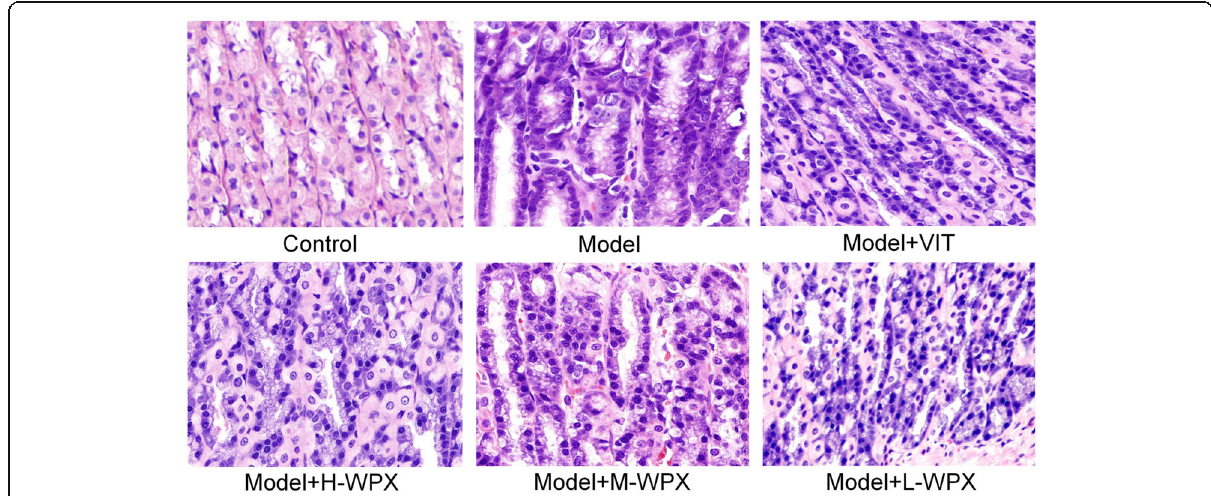
Fig. 3 Histological evaluation of gastric epithelial dysplasia. Model gastric epithelium displayed GED pathology characterized by glandular architectural abnormalities such as splitting, elongated and crowded glands, back to back formation, as well as by cytological atypia with rounded, pleomorphic nuclei that display prominent nucleoli and loss of polarity. After WPX intervention, these GED pathological alterations, especially irregularities of glandular structure, were regressed in varying degrees. n = 9 in each group. (H&E staining, 100×)